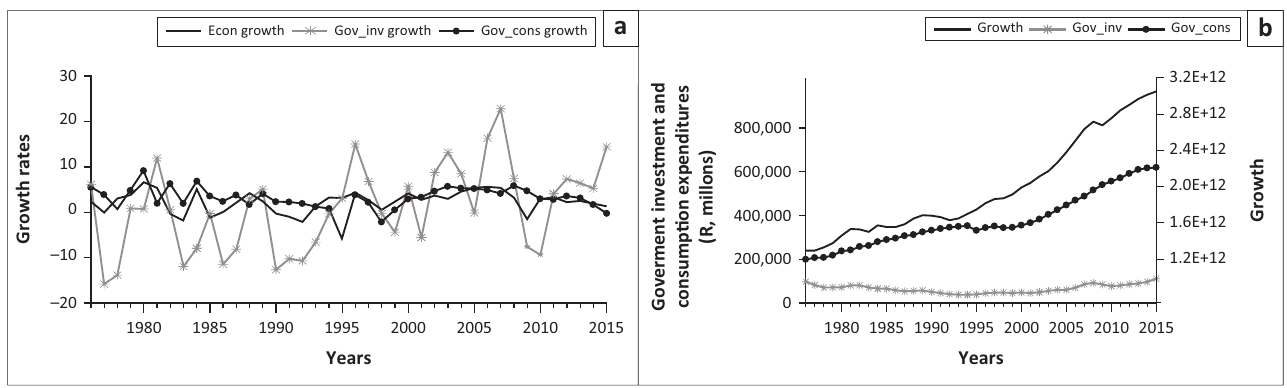
FIGURE 1: (a) Growth rates of gross domestic product (GDP), government investment and consumption spending: 1976–2015. (b) GDP growth, government investment and consumption spending: